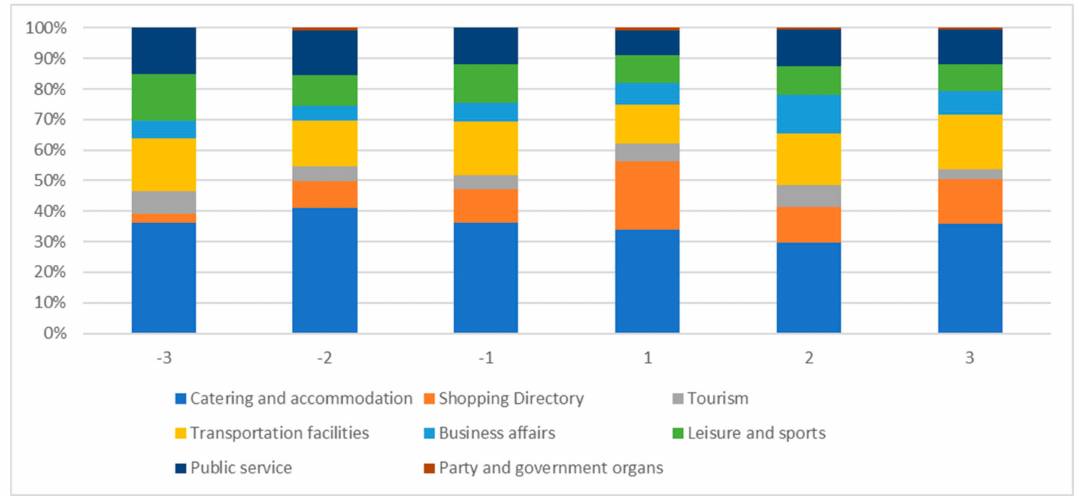
Figure 21. Ratio comparison of the POI dataset contained by hot/cold spots